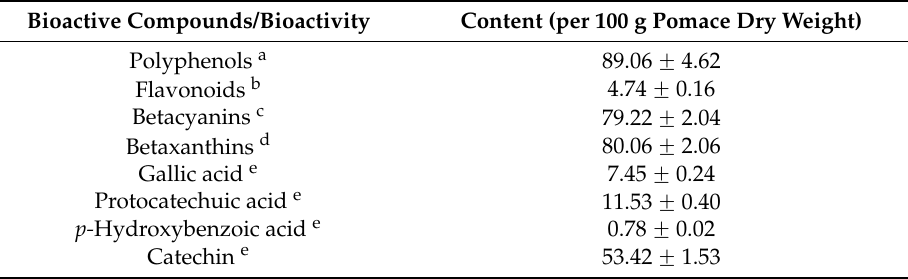
Table 1. The content of bioactive compounds and antioxidant activity of beetroot